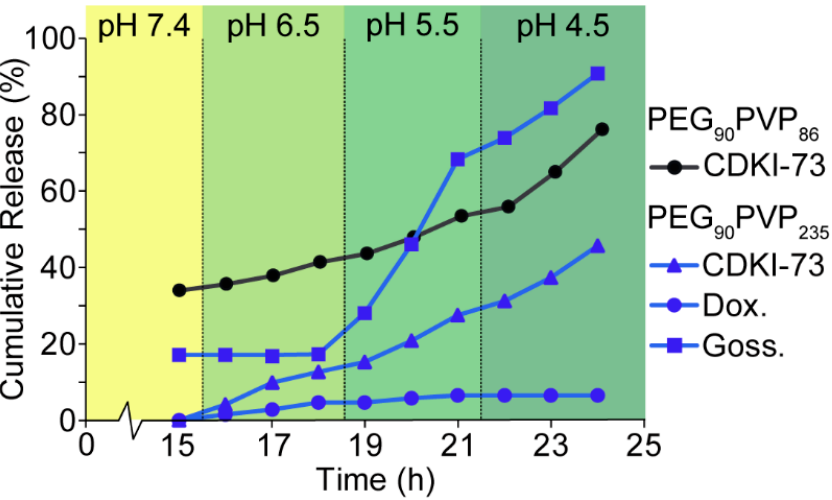
Figure 3. pH-dependent cumulative release plots for the PEG 90 PVP 86 and PEG 90 PVP 235 copolymers following the encapsulation of hydrophobic drugs CDKI-73, doxorubicin, or gossypol. Drug-loaded micellar solutions of concentration 1 mg·mL − 1 were used for all experiments, with a drug loading of 10 wt%.